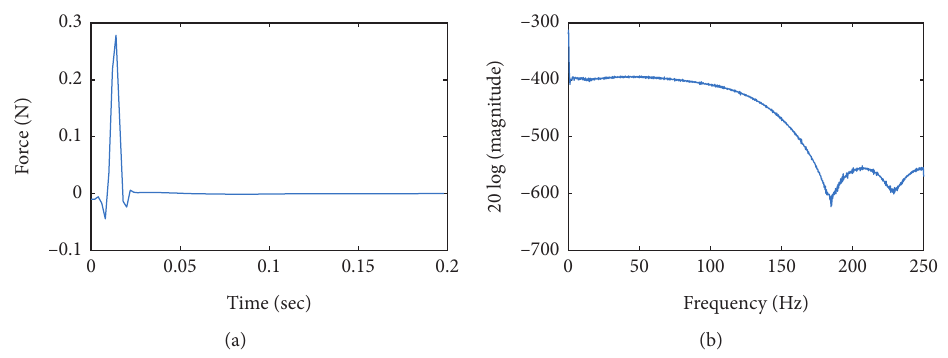
Figure 8: (a) Impact force at A5 and (b) auto spectrum of the impact